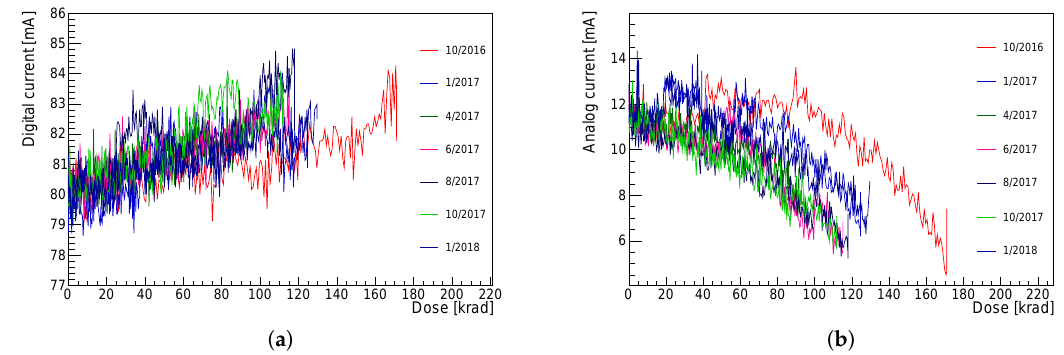
Figure 4. Digital ( a ) and analog ( b ) support currents versus total ionizing dose measured for different irradiation campaigns. The dates of the campaigns are listed in the legends.